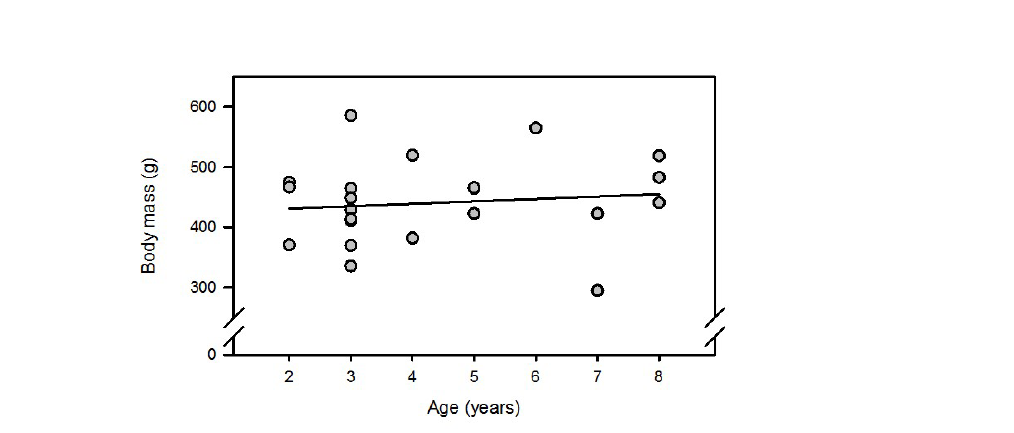
Figure A1. Regression analysis of body mass versus age of 23 intact PGF2 α -analogue-treated female marmoset monkeys 6 months from their last parturition. R = 0 . 12; n.s. (not significant).